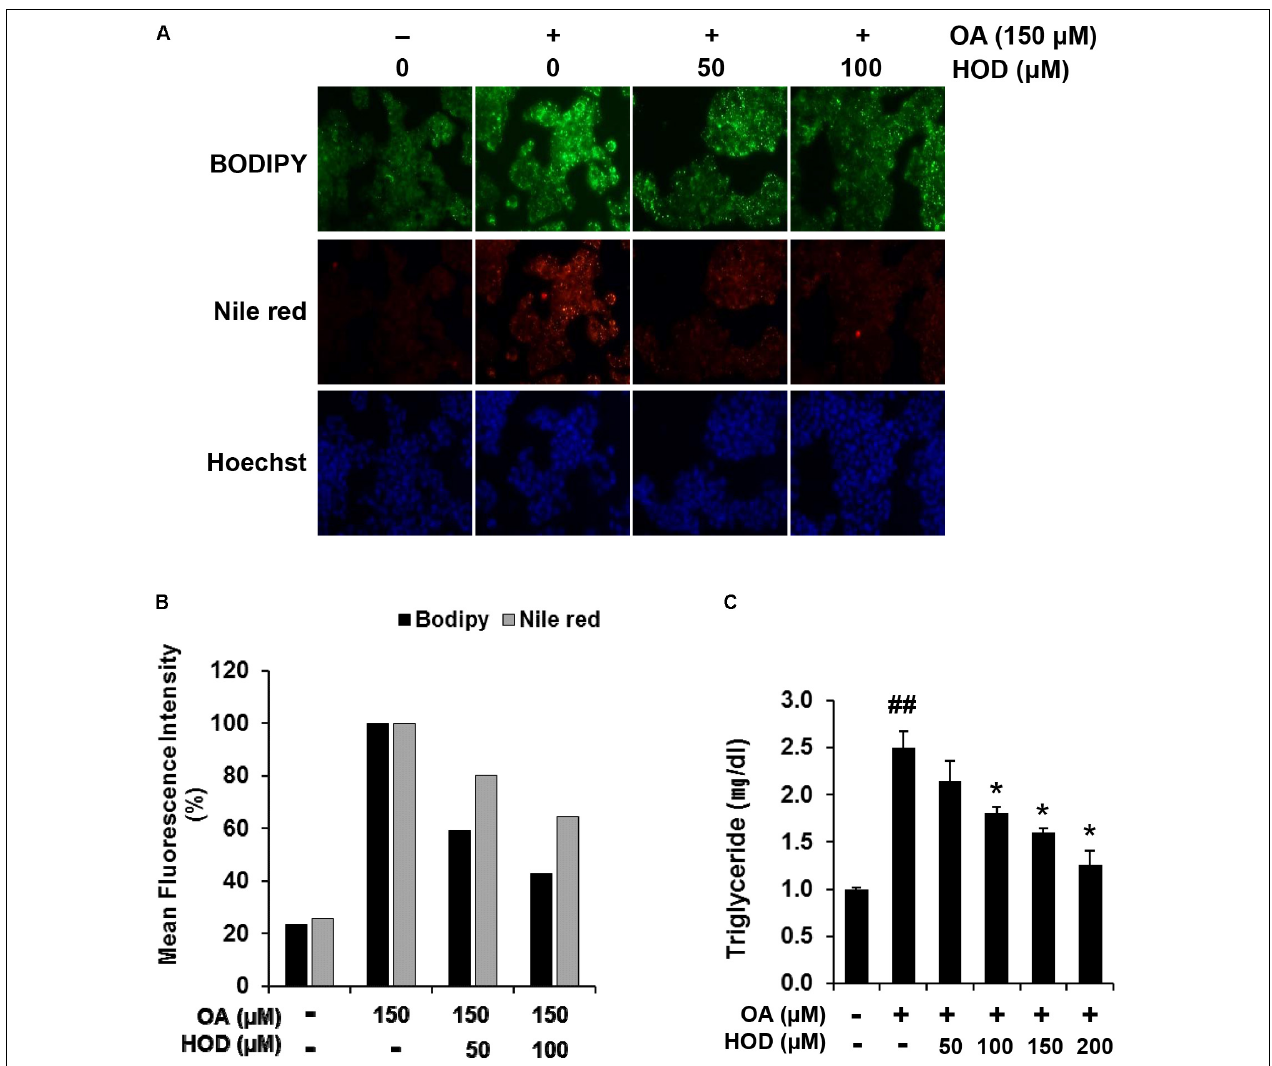
FIGURE 4 | HOD decreases the OA-induced intracellular lipid accumulation in HepG2 cells. (A) The cells were pre-treated with indicated concentrations of HOD for 1 h, followed by exposed to 150 µ M OA for 24 h. Lipid accumulation was determined by using BODIPY 493/503 and Nile red staining. Nuclei were counterstained with Hoechst 33342. (B) Quantitative analysis was performed after BODIPY 493/503 and Nile red staining by using the flow cytometry in the FL-1H and FL-2H channel, respectively. (C) Quantification of TG contents by using commercial kit. The bar graphs show the mean ± S.D. of 3 independent experiments ( ## p < 0.01 compared with the DMSO control; ∗ p < 0.05 compared with the OA-treated